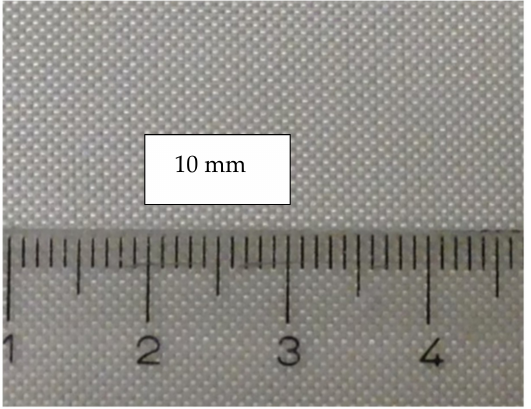
Figure 1. The high-strength (HS glass) fabric with a woven pattern plain was used in the FRC retainer. The direction in the strand for the retainer was 90/0 ◦